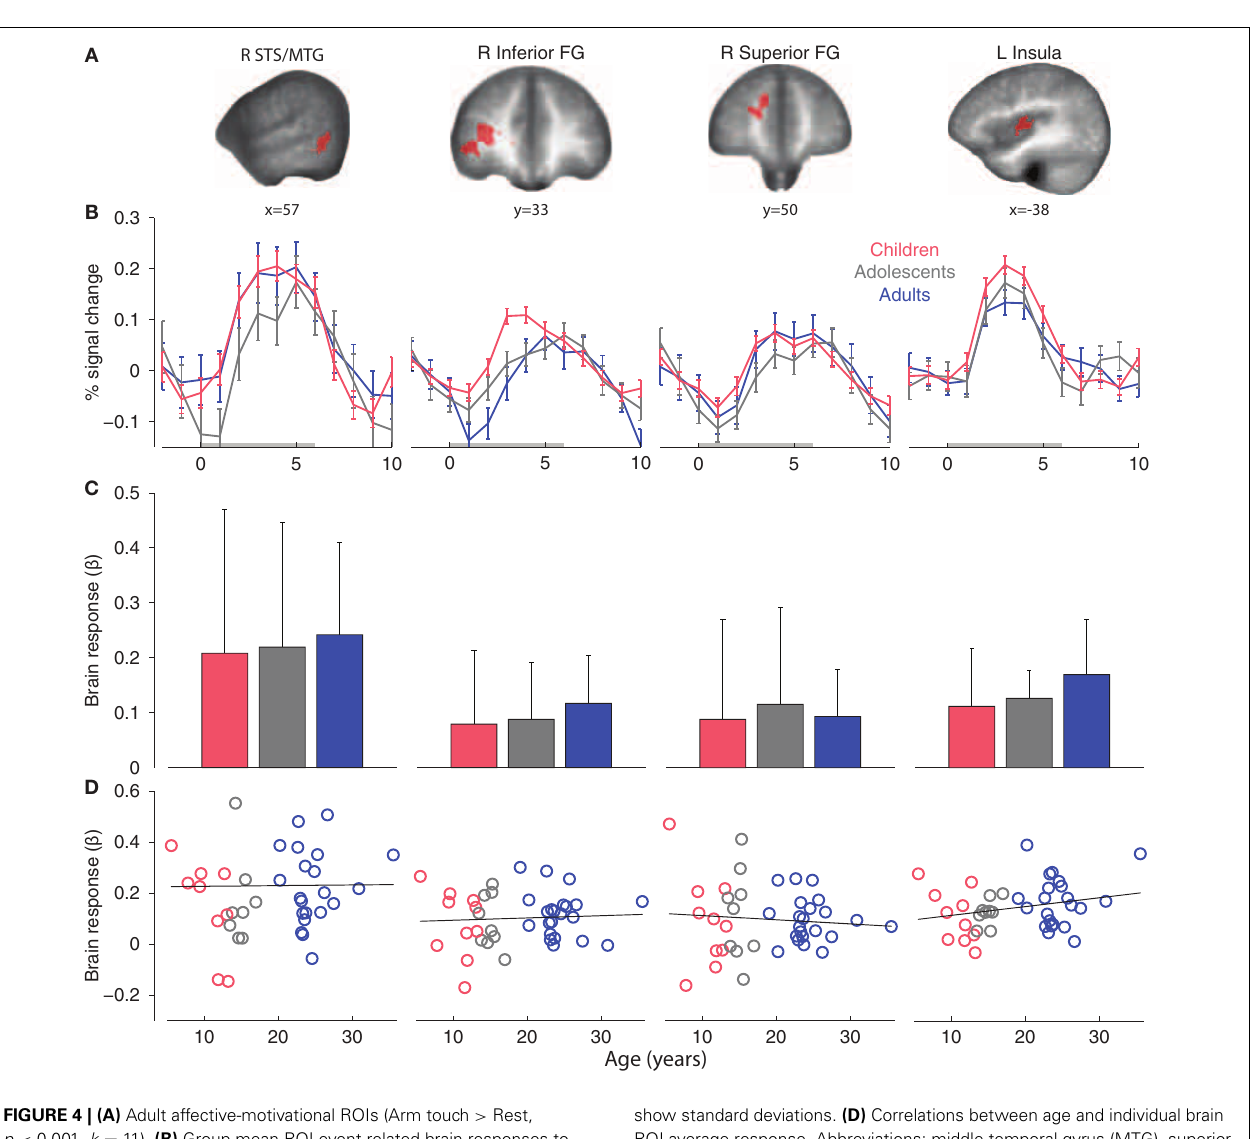
show standard deviations. (D) Correlations between age and individual brain ROI-average response. Abbreviations: middle temporal gyrus (MTG), superior temporal sulcus (STS), frontal gyrus